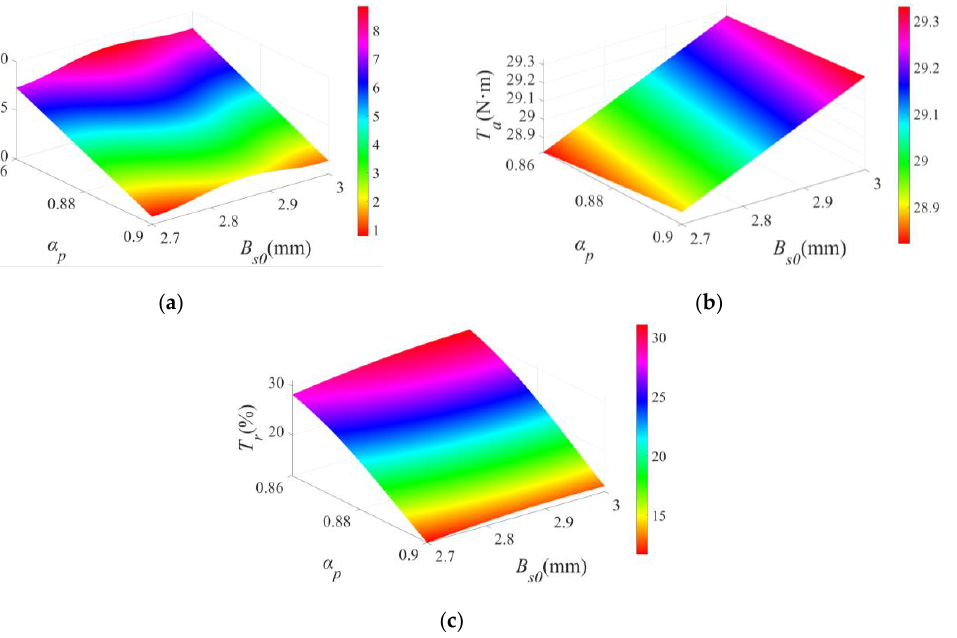
Figure 5. Response surface diagram: ( a ) the response surfaces of α p , B s0 and T c ; ( b ) the response surfaces of α p , B s0 and T a ; ( c ) the response surfaces of α p , B s0 and T r .